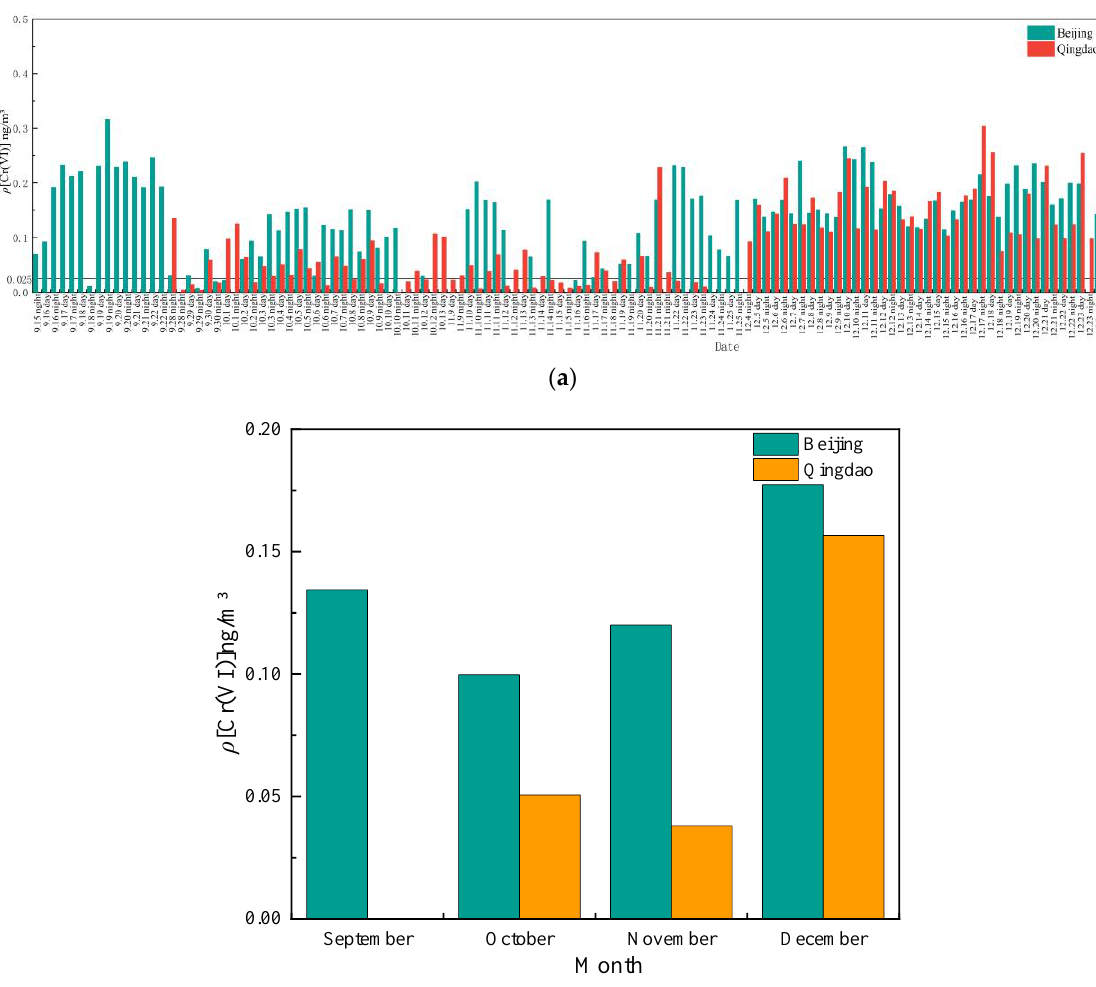
Figure 2. The diurnal variation ( a ) and monthly variation ( b ) of Cr(VI) Concentration in Beijing and Qingdao.